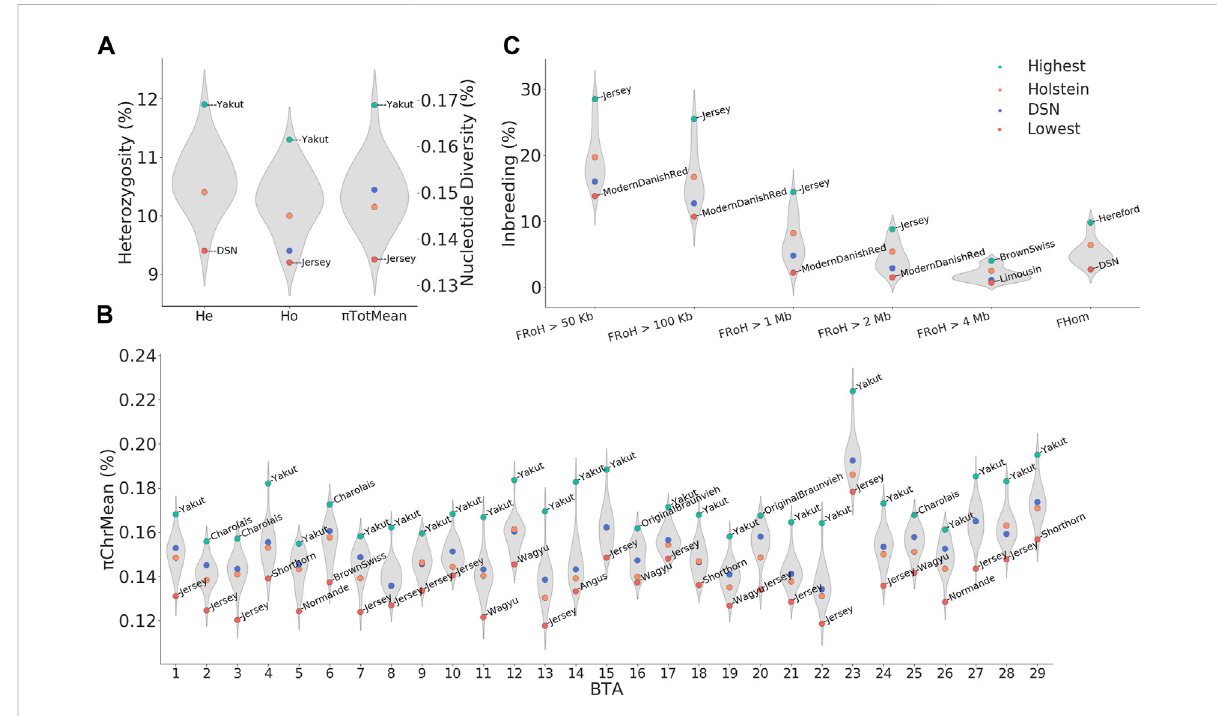
FIGURE 3 Overview of diversity measurements and inbreeding across breeds. (A) Average nucleotide diversity ( π TotMean ) observed heterozygosity (H o ), andexpected heterozygosity (He) distributions, (B) average nucleotide diversity per chromosome ( π TotMean ), (C) inbreeding de fi ned based on runs ofhomozygosity (F RoH ) and excess of homozygosity (F Hom ). Values for DSN and Holstein are highlighted in blue and orange, respectively. For each distribution, the highest and lowest values are highlighted in green and red, respectively, including the respective breed names.